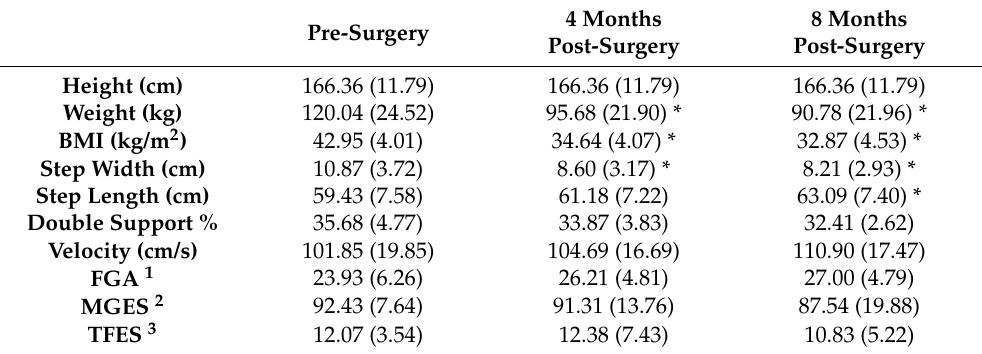
Table 1. Descriptives and spatiotemporal gait parameters during initial baseline walking across visits and assessment scores. Standard Deviation scores are in